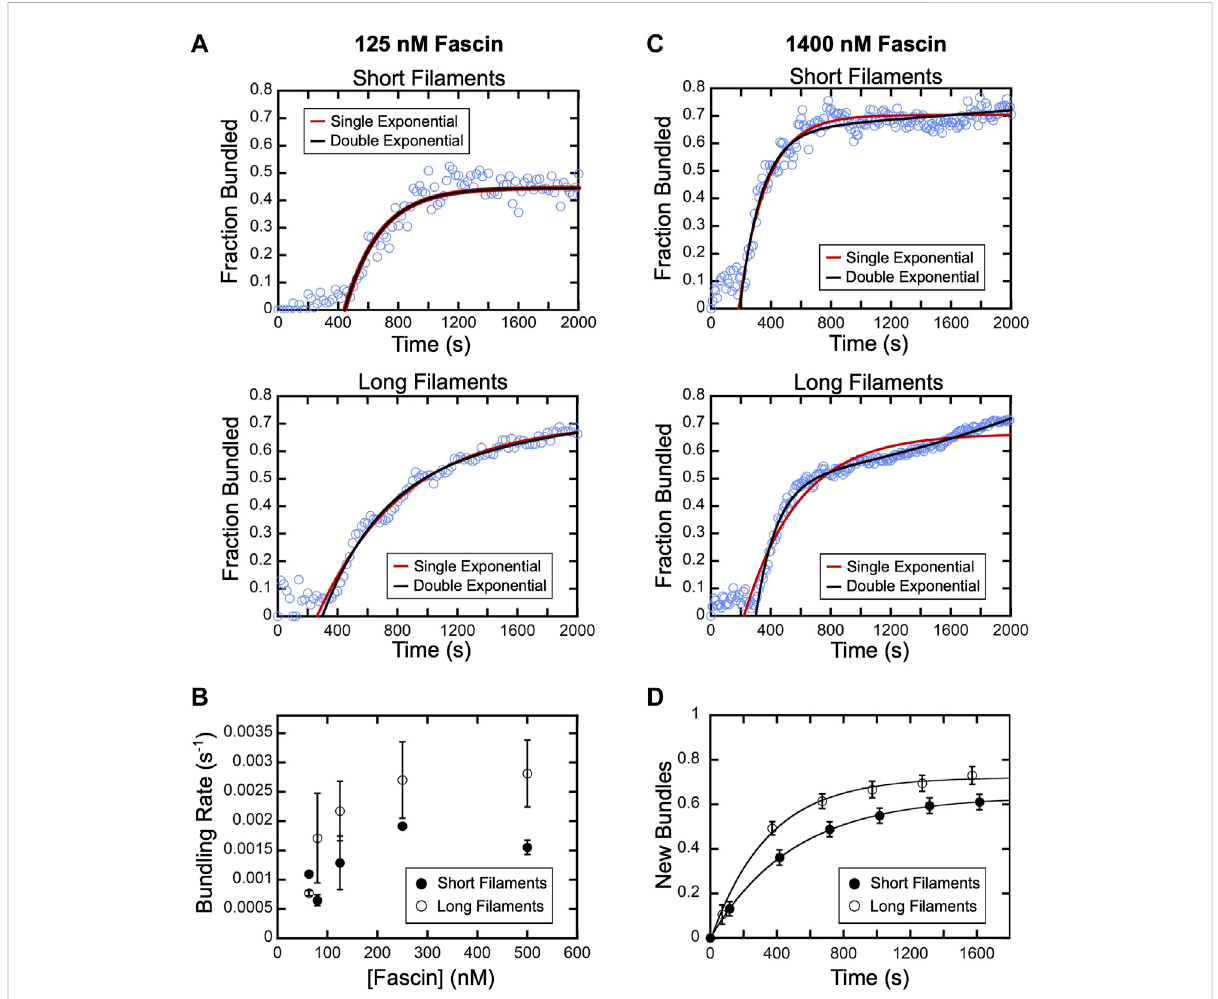
FIGURE 4 Fascin-mediated bundling occurs via distinct phases. A range of concentrations of fascin was introduced into reactions containing FITC- phalloidin-labeled actin fi laments. (A) The fraction of the fi lamentous actin that is bundled over time in representative reactions containing 125 nM fascin and short (top) or long (bottom) fi laments. Red and black lines are single and double exponential fi ts to the data. (B) Bundling rates for short (closed circles) and long (open circles) actin fi laments obtained from single exponential fi ts to bundling pro fi les collected at sub-saturating fascin concentrations. Error bars are the standard error of the mean bundling rate measured in at least three independent experiments. (C) The fraction of the fi lamentous actin that is bundled over time in representative reactions containing 1,400 nM fascin and short (top) or long (bottom) fi laments. Red and black lines are single and double exponential fi ts to the data. (D) New bundles assembled from short (closed circles) and long fi laments (open circles) over time in the presence of 1,400 nM fascin. To facilitate comparison, the number of bundles that are assembled de novo over time was normalized to the number of fi laments present at the beginning of each reaction. Lines are single exponential fi ts to the data, which yield rates of new bundle formation of 0.002 s − 1 and 0.003 s − 1 for reactions containing short and long fi laments, respectively. Error bars are the standard error of the mean number of bundles measured in at least three independent